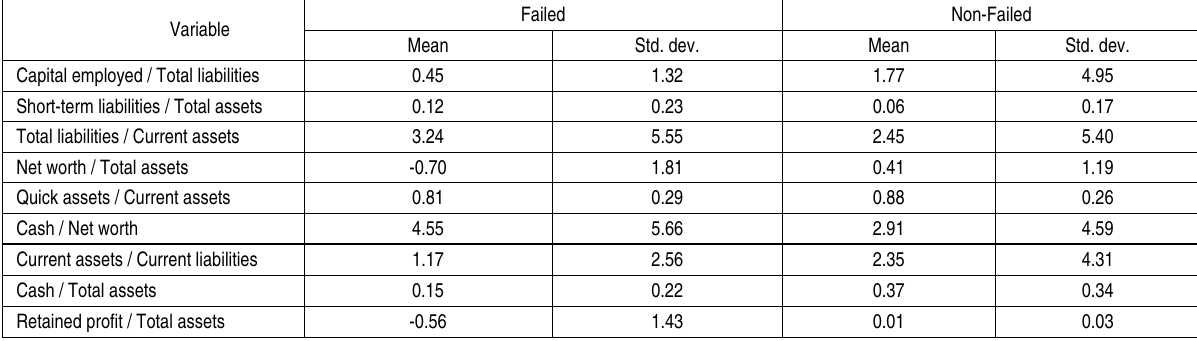
Table A.1. Descriptive statistics of the quantitative predictor